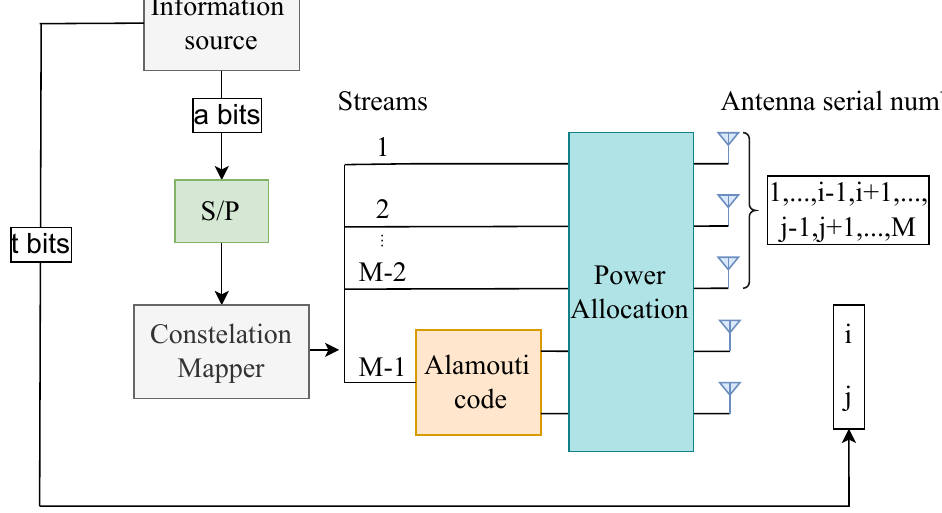
Figure 2. Block diagram for the STBC-VBLAST-SM